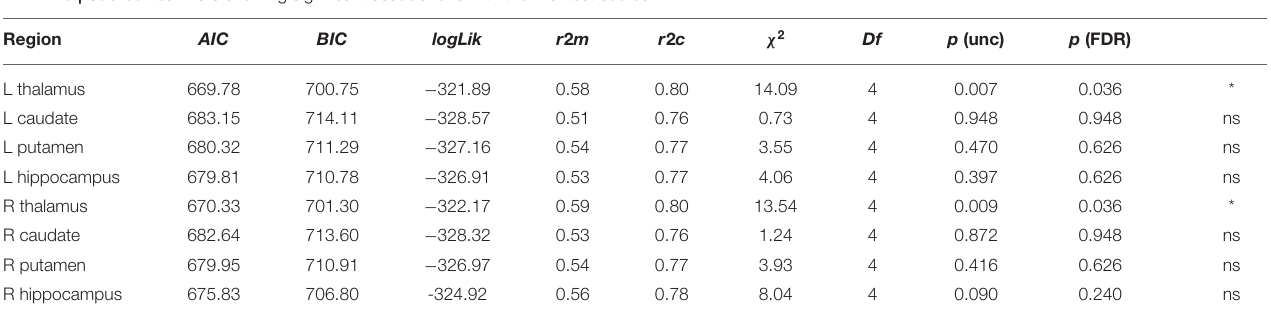
TABLE 5 | Sub-cortical ROIs showing significant associations with the final test scores.